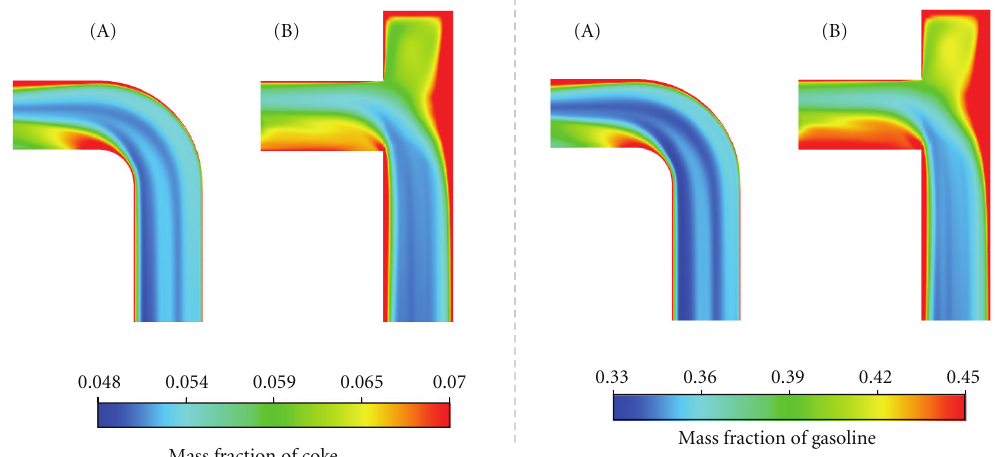
Figure 14: Mass fractions of coke and gasoline for Cases 1 (A) and 5 (B).